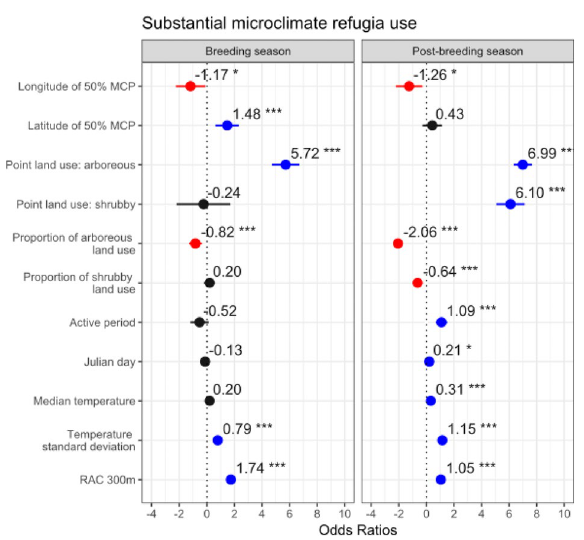
Figure 4. GLMM results for the predictors of microclimate refugia use, for both breeding and post-breeding seasons. Variable significancy is shown: *** p < 0.01; * 0.01 < p < 0.05; others, p > 0.05. Positive effects are shown in blue, negative effects in red and not significant effects in